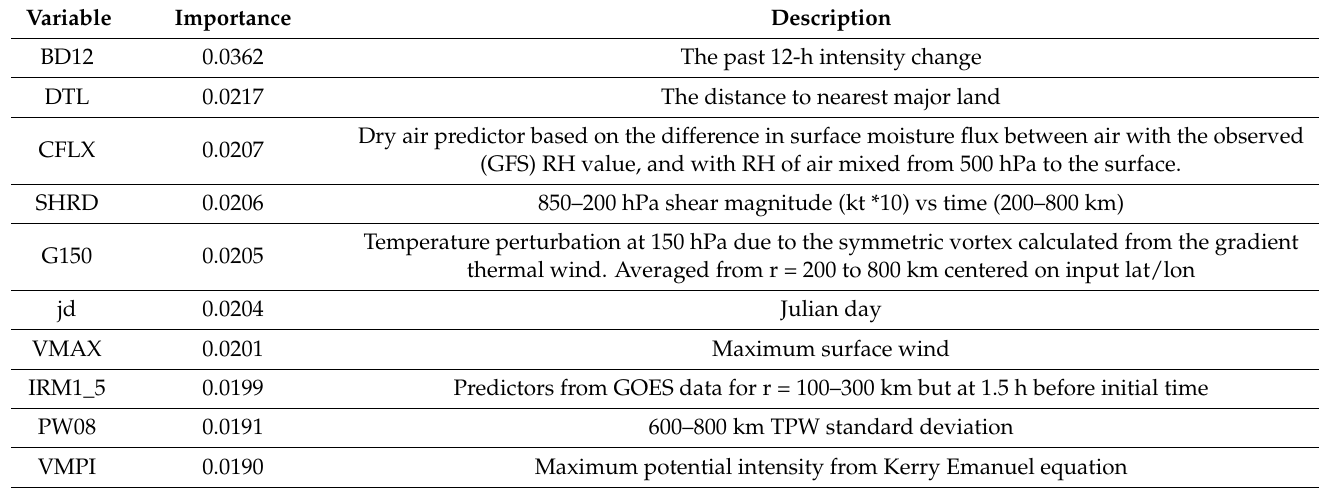
Table 10. Features of top ten importance, their importance scores, and feature description from